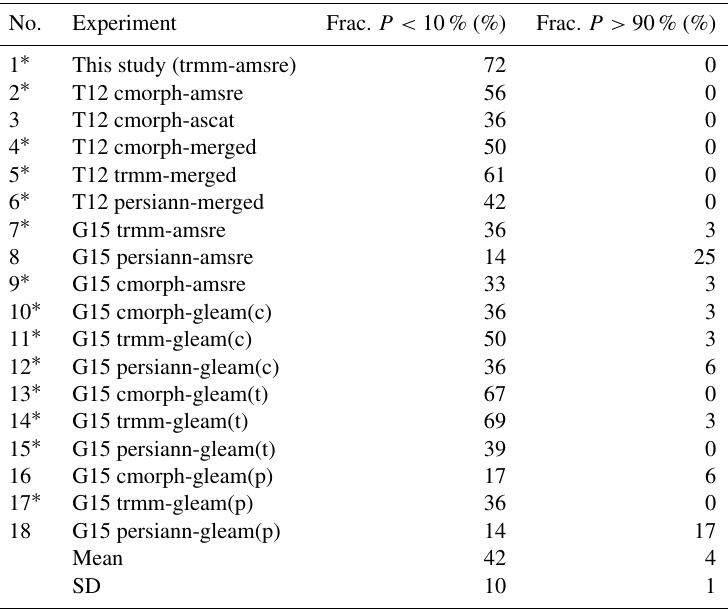
Table A1. Percentage of 5 ◦ × 5 ◦ grid boxes with significantly negative ( P e < 10%) and positive ( P e > 90%) spatial SMPC over the North African domain in this study and previous studies of T12 and G15. Different data set combinations used in T12 and G15 are listed. “Merged” represents an integrated product composed of grid boxes in which either the AMSR-E or the ASCAT soil moisture data set was identified to be the best following a quality-control check. Following visual inspection, the experiments in which a significant negative SMPC relationship exists in the western region of the Sahelian domain are indicated with a ∗ sign. For more details on various data set combinations, the reader is referred to the original